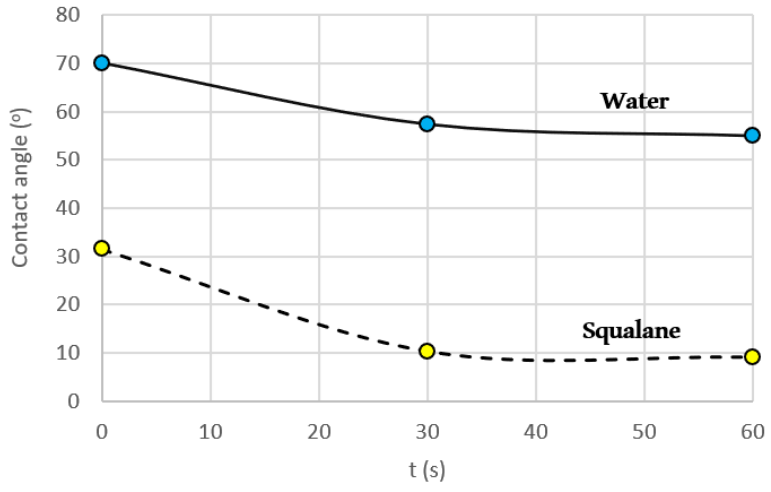
Figure 4. Static contact angle variation, experimental results within 60 s, for water (•) and squalane (•).